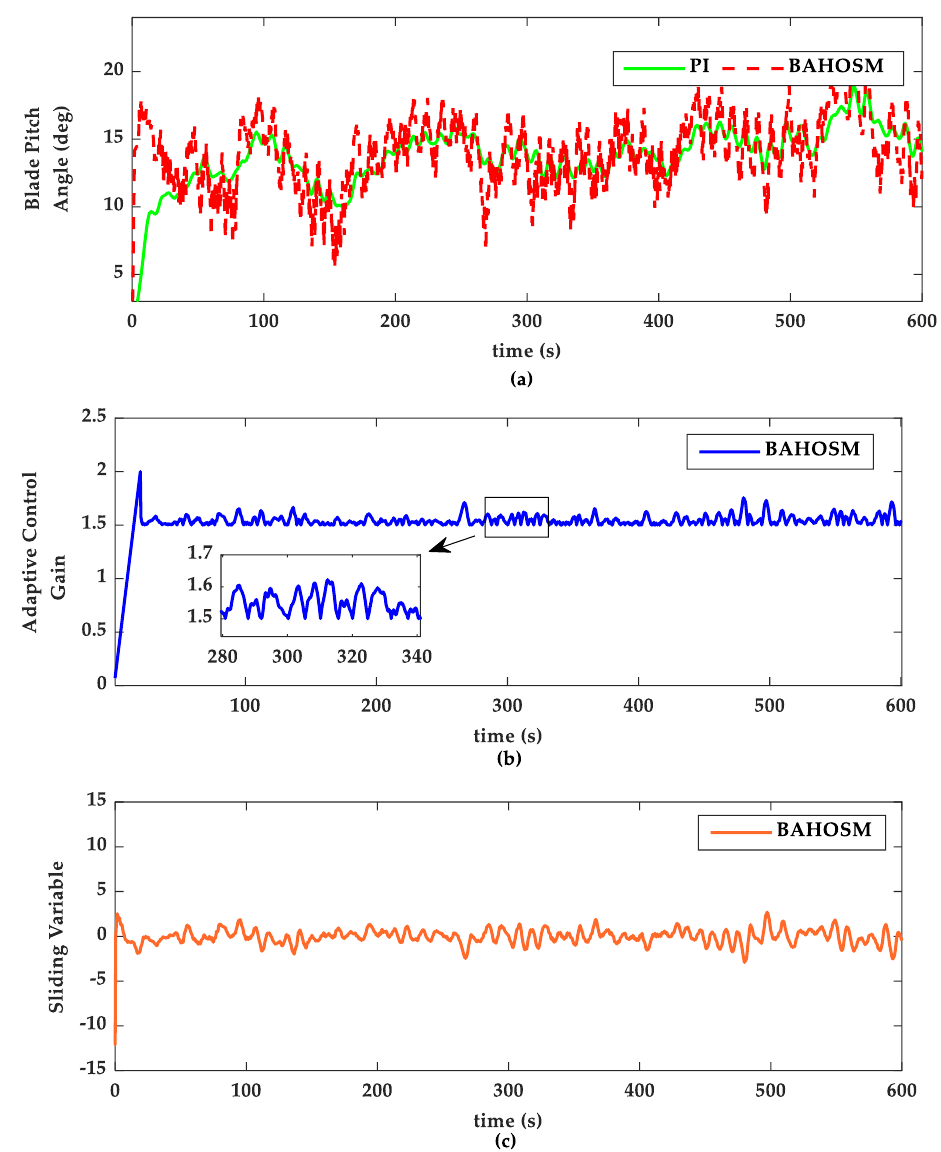
Figure 11. Blade pitch angle output ( a ) by BAHOSM controller gain L ( b ) and sliding variable s ( c ) in Case 1.